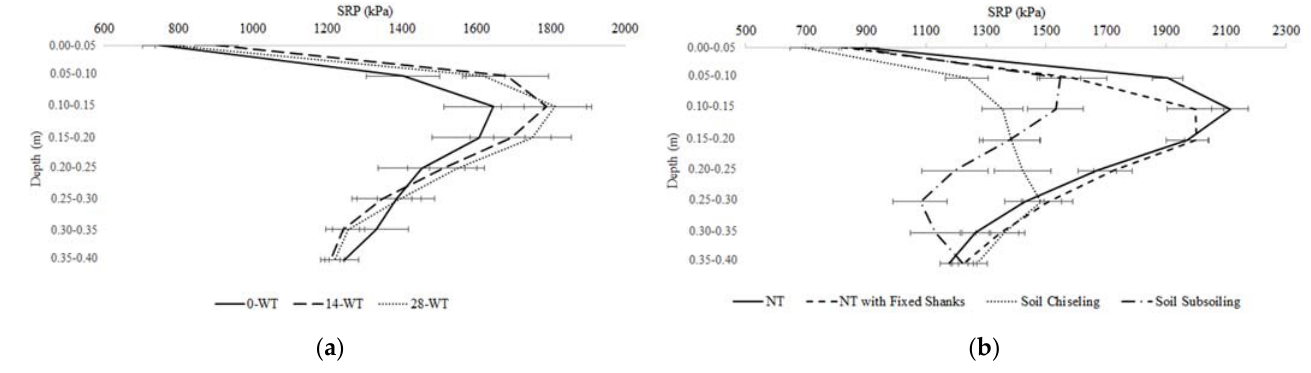
Figure 3. Soil penetration resistance (SRP, kPa). ( a ) Values for wheel traffic (WT); ( b ) Mechanical interventions up to a depth of 0.40 m. (Bars were calculated using standard error). WT: wheel traffic. NT: no-till. NT + FS: no-till with fixed shank. SC: Soil chiseling. SSS: Soil subsoiling.